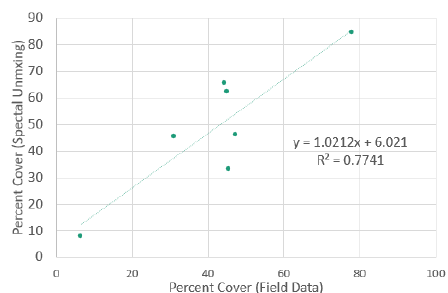
Figure 14. Validation of seagrass spectral unmixing using seagrass percent cover gathered from field surveys